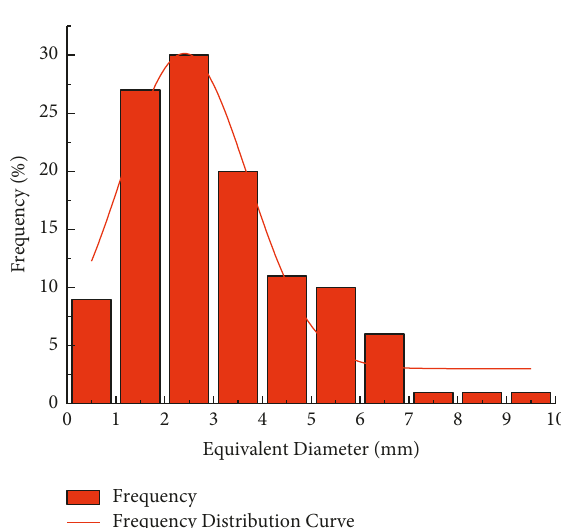
Figure 4: Equivalent diameter of OGFC-1.